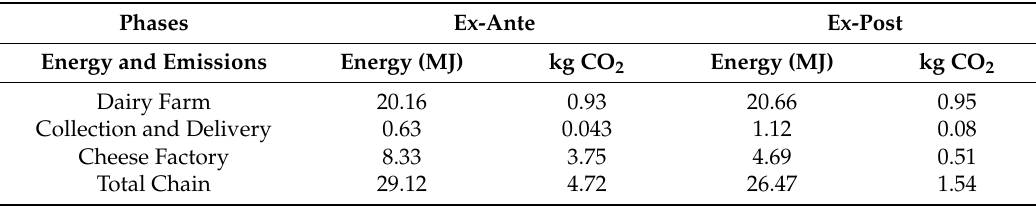
Table 6. Energy and carbon dioxide emissions summary, in the ex-ante and ex-post phase, reported for each main production step (from dairy farm to cheese factory) expressed per 100 kg of